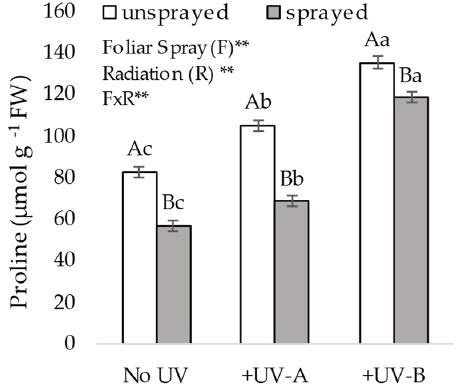
Figure 2. Effect of UVR regimen and/or mitigating treatments on Proline content. FW (fresh weight). Same uppercase letters within sprayed/unsprayed (intra-treatment) or the same lowercase letters across UVR regimens (inter-treatment) indicate no difference using Tukey’s test ( p < 0.05). ** denote significance among foliar spray and UV radiation, according to the Tukey test (ANOVA).